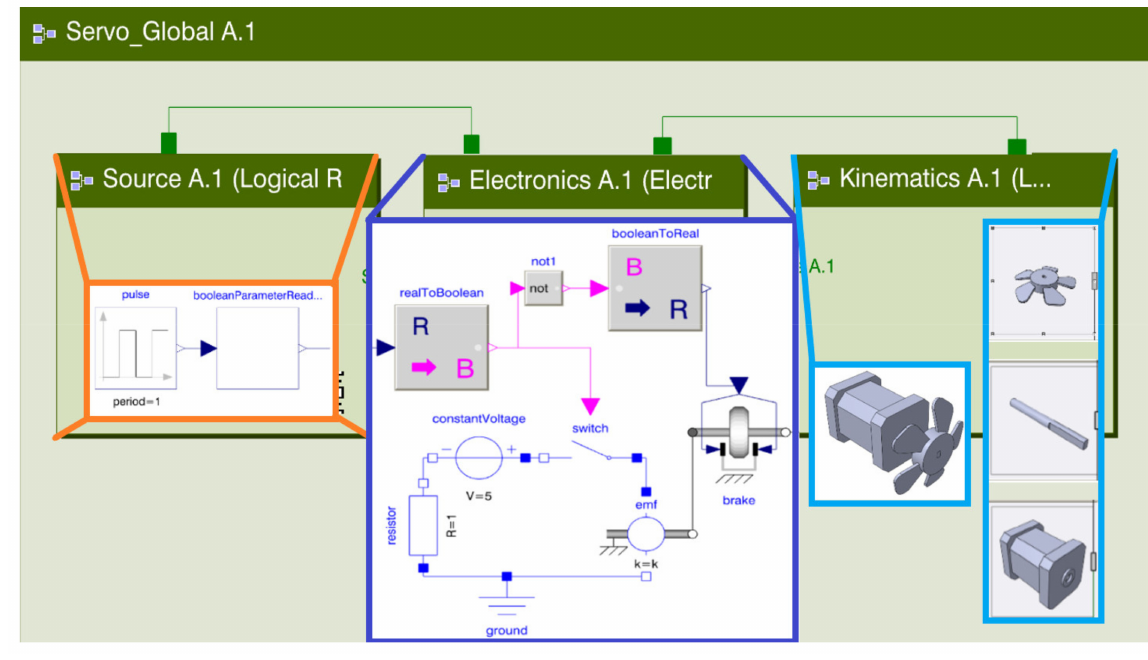
Figure 10. Systems Model of Servo Motor